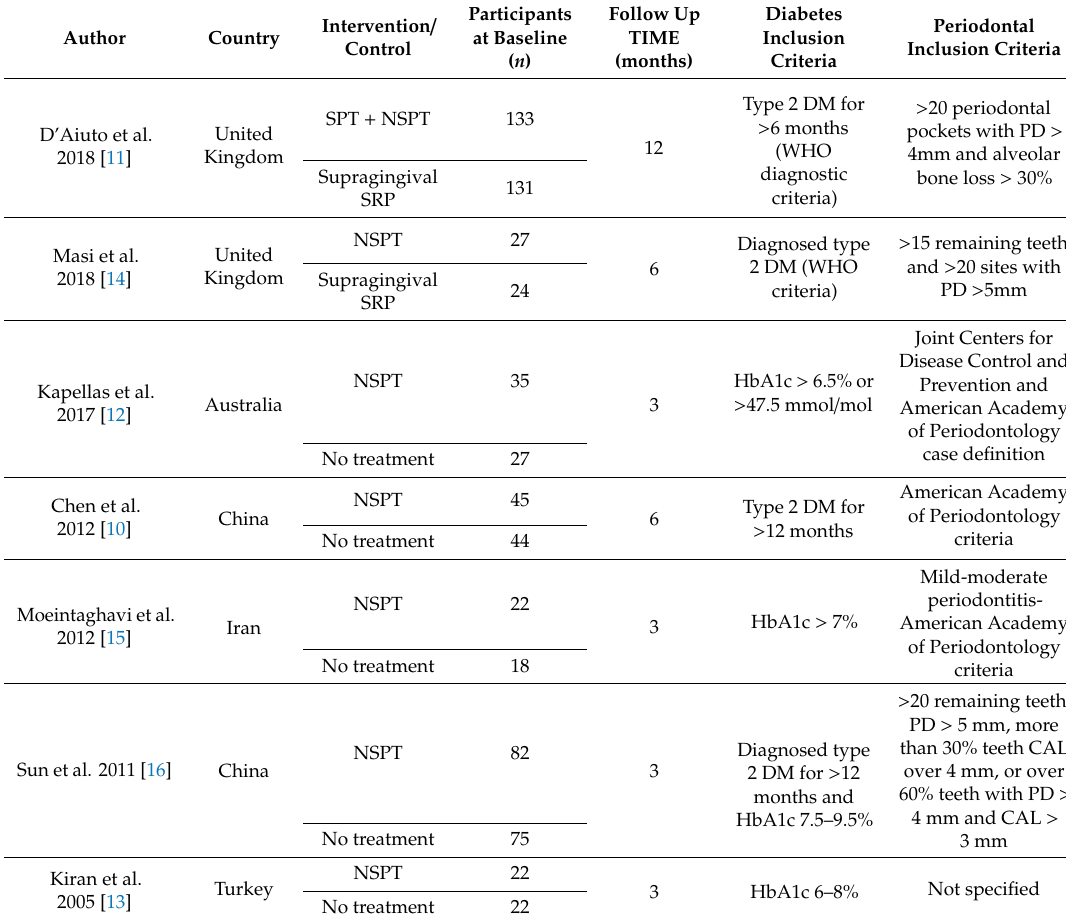
Table 1. Characteristics of included